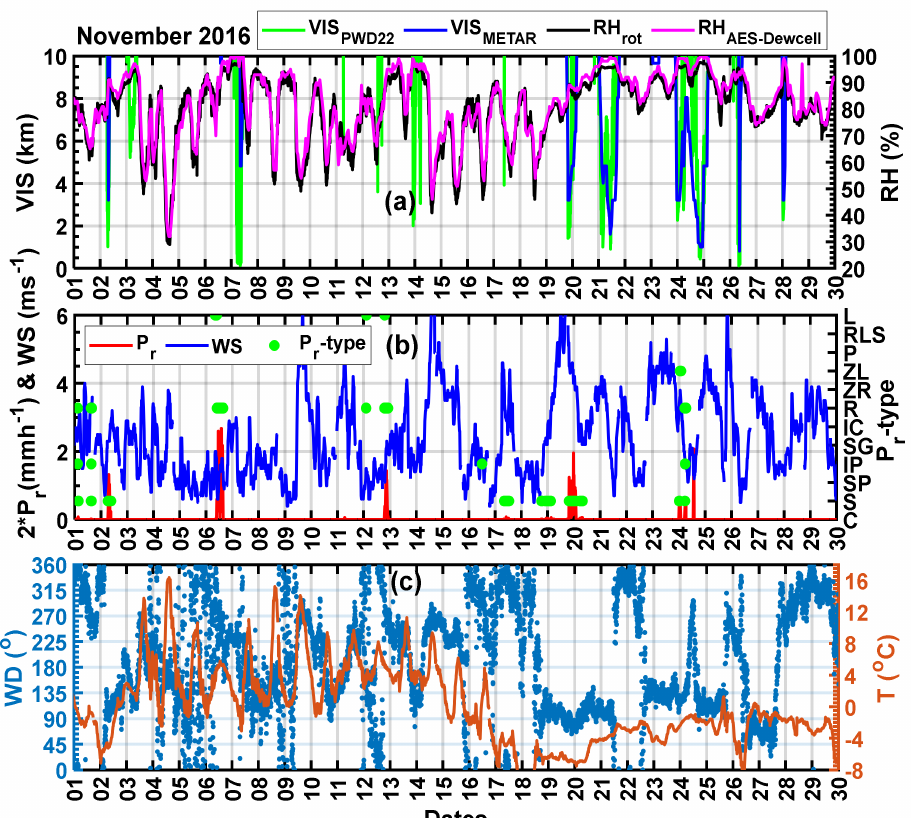
Figure 2. ( a ) The observed visibilities based on both PWD22 and METAR (VIS PWD22 and VIS METAR ) and RH (RH METAR and RH AES-Dewell ); ( b ) wind speed (WS), precipitation and type; ( c ) temperature (T) and wind direction. Precipitation type symbols (c = clear, SP = snow pellets, IP = ice pellets, SG = snow grain, IC = ice crystals, R = rain, ZR = freezing rain, ZL= freezing drizzle, P = unknown, RLS = rain + drizzle + snow, and L =